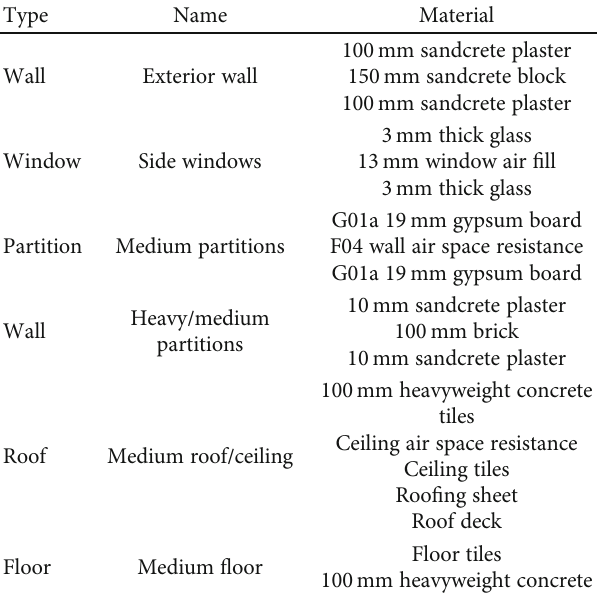
Table 1: Building speci fi cation. Table 2: Zones and their internal gains for the administration